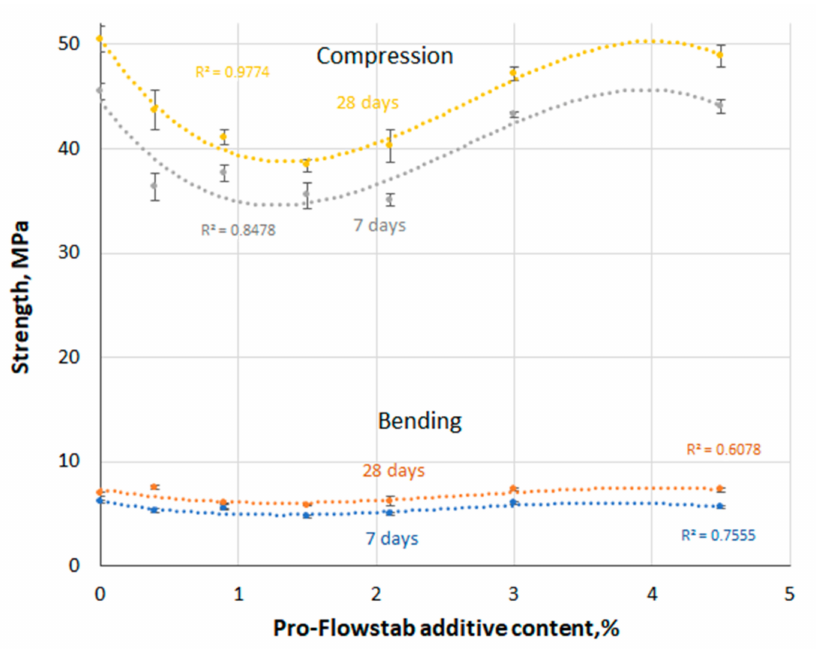
Figure 5. Results of determining the strength of series A specimens in bending and